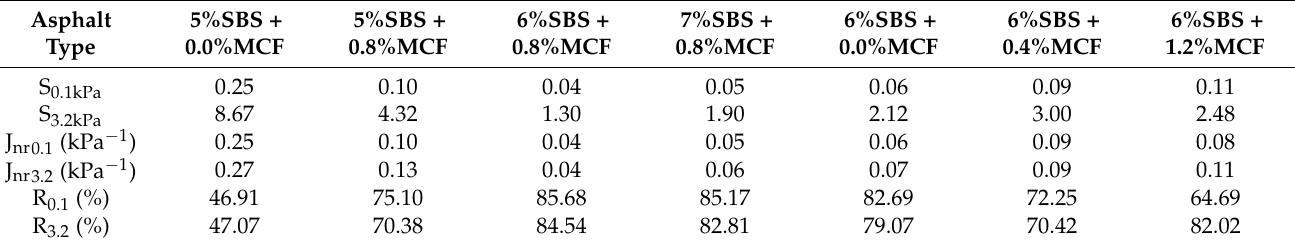
Table 6. MSCR test results for the modified